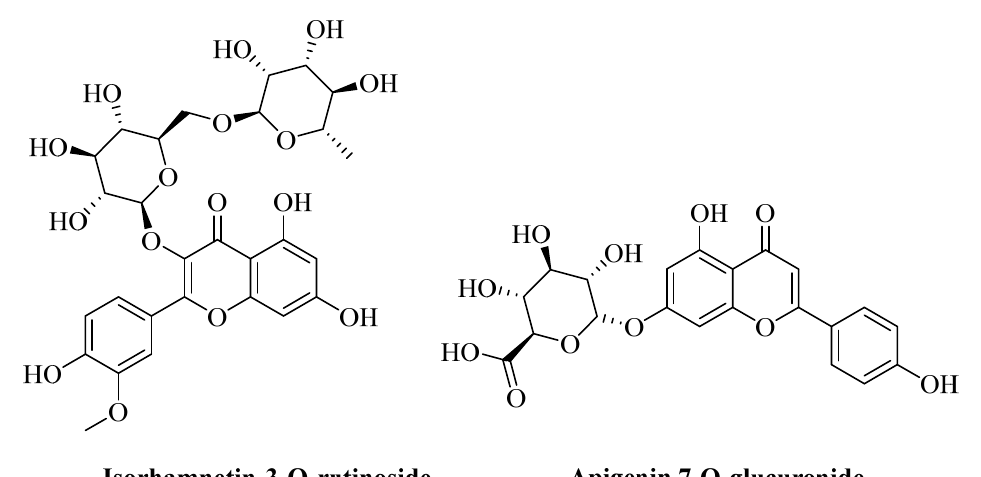
Figure 1. Chemical structure (drawn using PubChem Sketcher V2.4) of flavonoids and their glyco- sides .